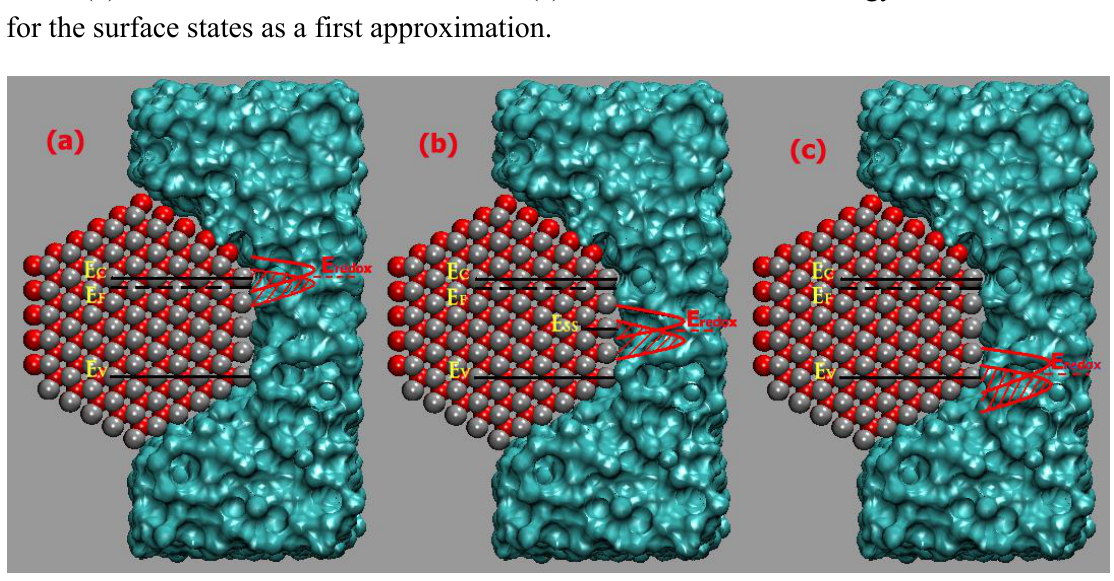
(a), with surface C (c), where the discrete energy level is assumed V